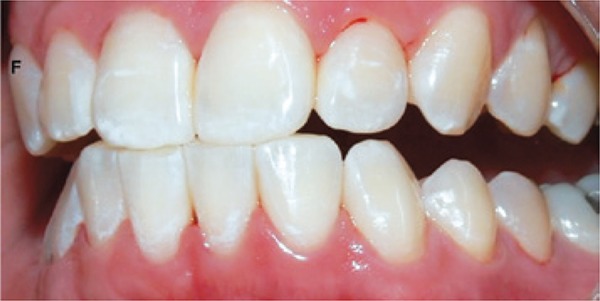
Dentes com fluorose muito leve